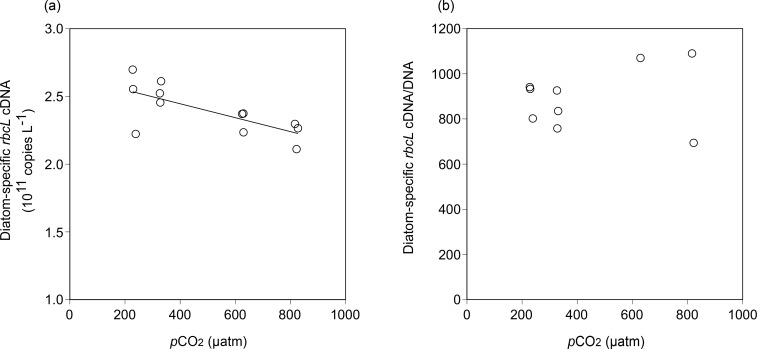
Relationships between seawater pCO2 (calculated values from TA and DIC) and (a) diatom-specific rbcL cDNA copies and (b) diatom-specific rbcL cDNA copies normalized to rbcL gene copy on day 3.